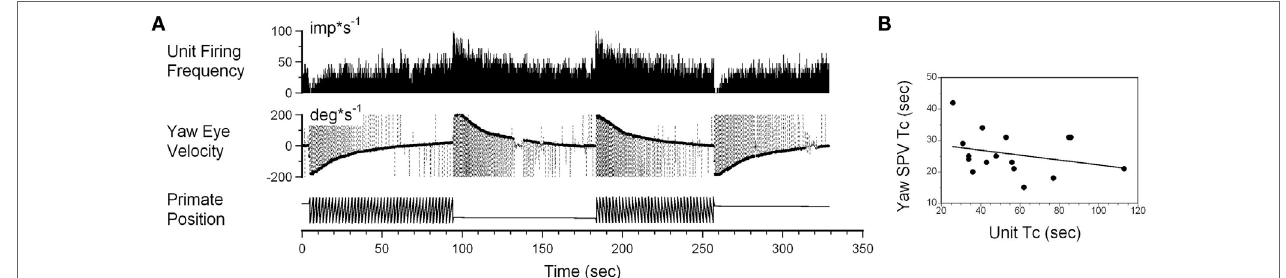
FigUre 6 | (a) Changes in the neuronal firing rate induced by head rotation about a spatial vertical axis of vestibular-only neuron that does not code the yaw component of velocity storage. See also legend to Figure 5 for details. (B) Changes in the time constant determined from yaw slow phase eye velocities (ordinate) did not correlate with changes determined from the neuronal firing rate